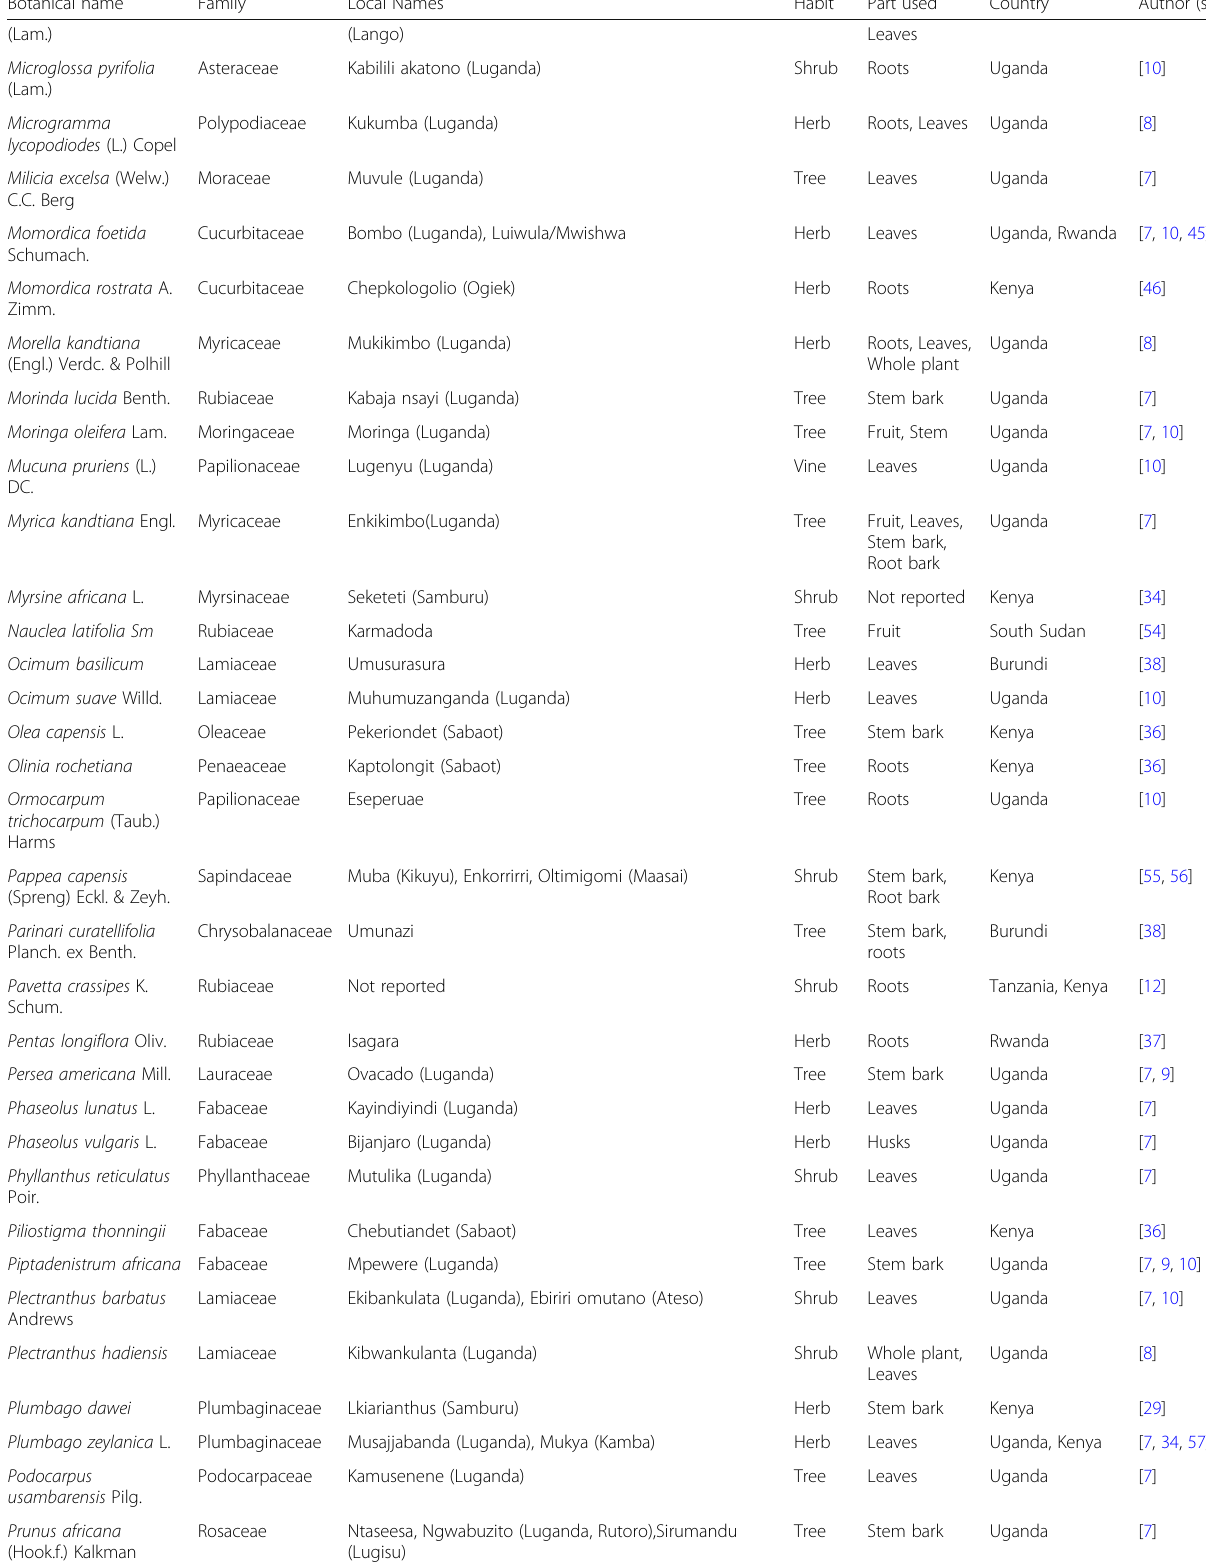
Table 1 Medicinal plants used in treatment of symptoms of TB in East Africa (Continued) Botanical